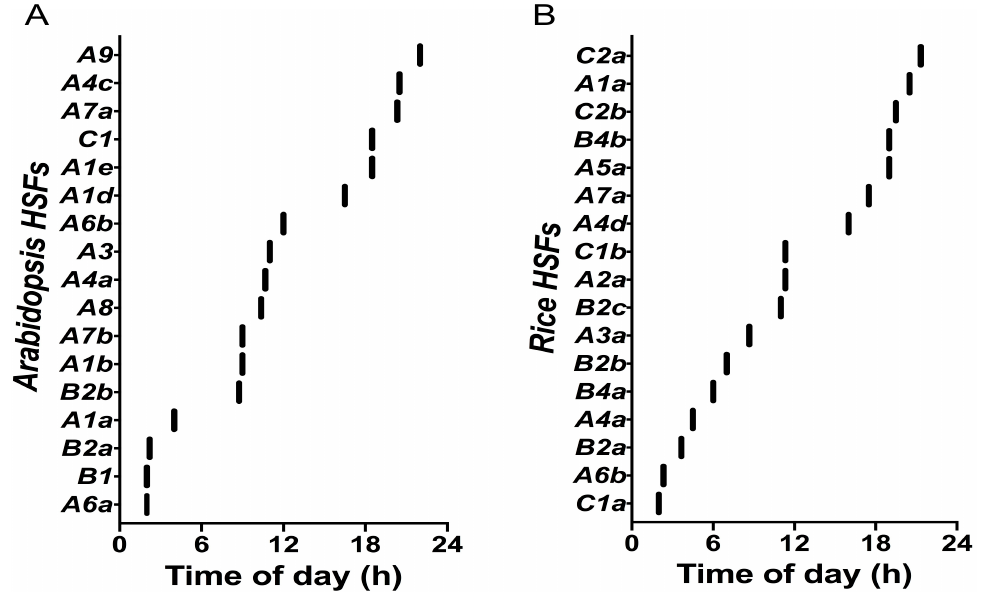
Figure 3. Timing of peak expression (phase) for plant heat shock transcription factors ( HSFs ) in ( A ) Arabidopsis (AtHSFs) and ( B ) rice (OsHSFs) . The phase data was obtained from DIURNAL, and the average phase was calculated across all conditions available in DIURNAL for each plant species [29].